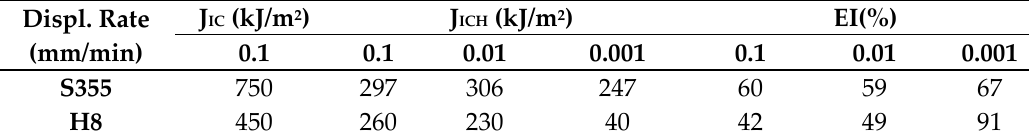
Table 2. Fracture toughness results and embrittlement